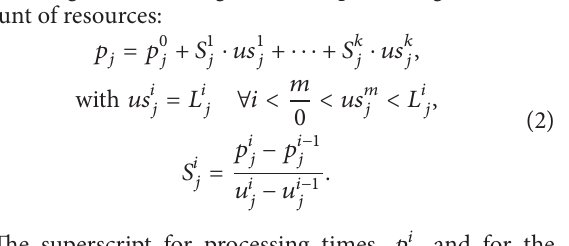
efficiency (point [𝑅 𝑗 , 𝑝𝑑 𝑗 ] ). Therefore, it is easy to see that the linear approach is not flexible to this concept, at least for values to each side of the efficiency level since the efficiency point of worker must always be in an extreme of the line (see, e.g., Figure 2(a), where the efficiency point is placed for 𝑎/𝑏